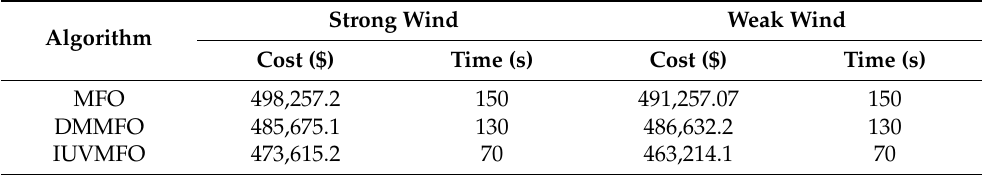
Table 13. Comparison of results for economic dispatch of cogeneration. Figure 19. Curve diagram of algorithm test result.